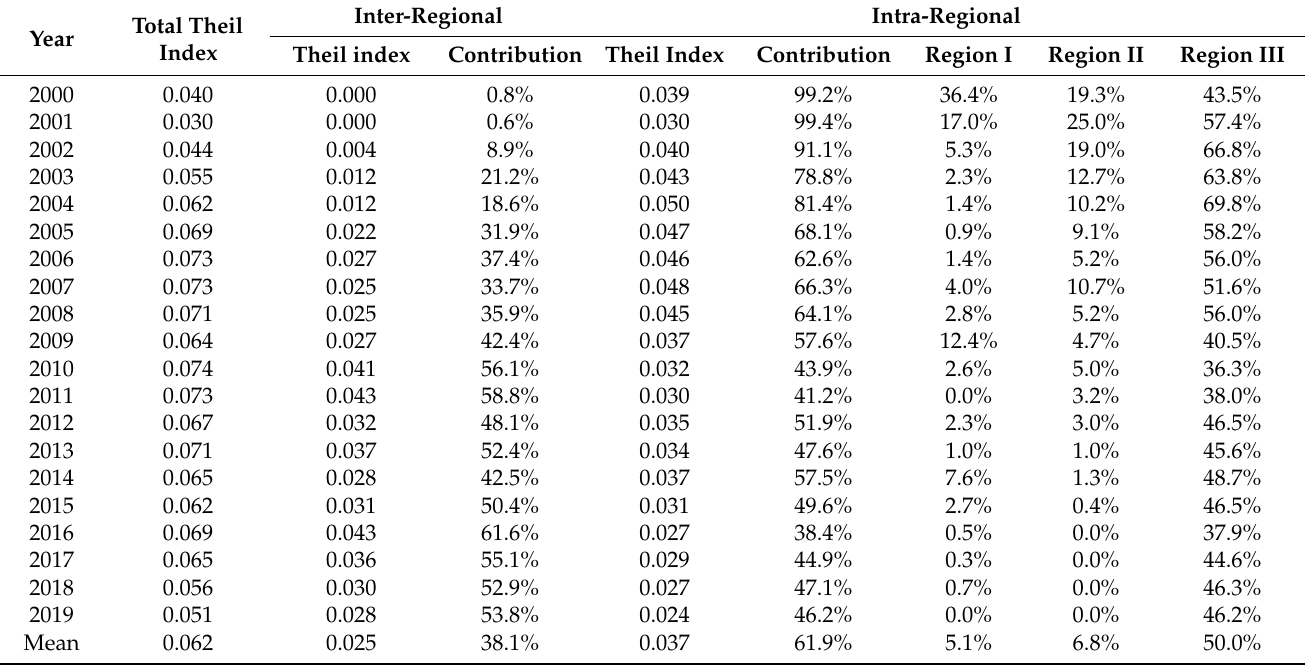
Table 4. Theil index values of NCSPC in the principal grain-producing area of China from 2000 to